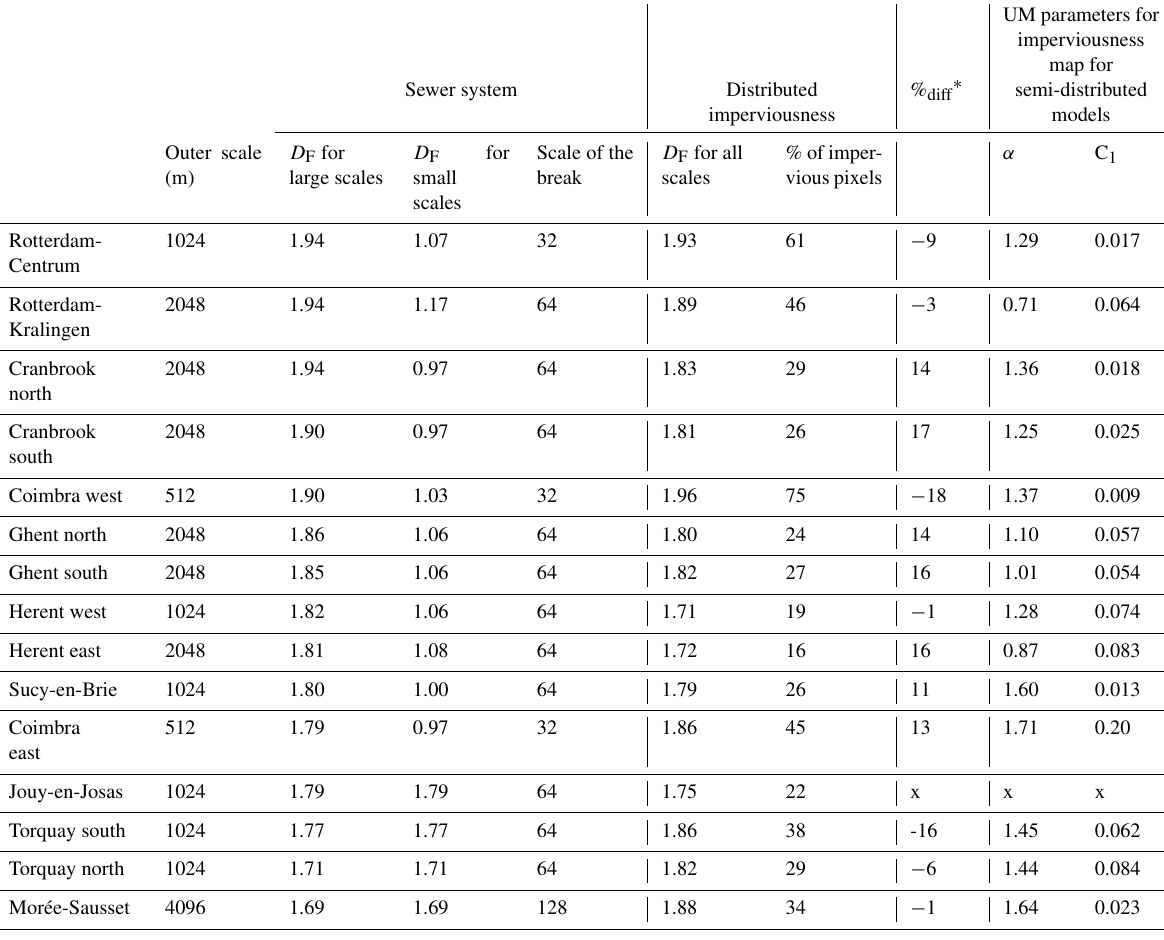
Table 2. Estimated fractal dimensions of the sewer system and impervious areas for all the studied areas.